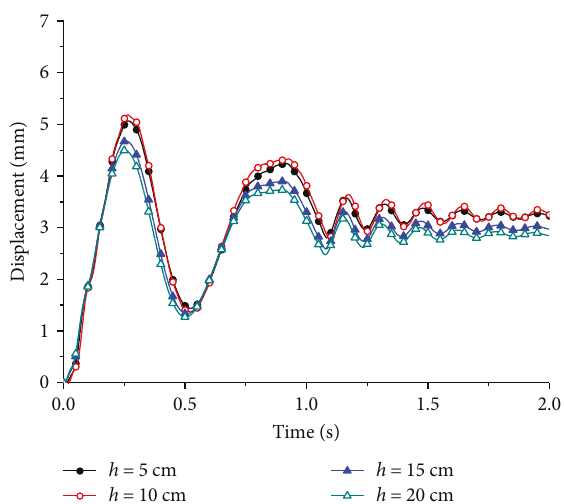
Figure 21: Longitudinal displacement of launch canister top in di ff erent surface layer thicknesses.